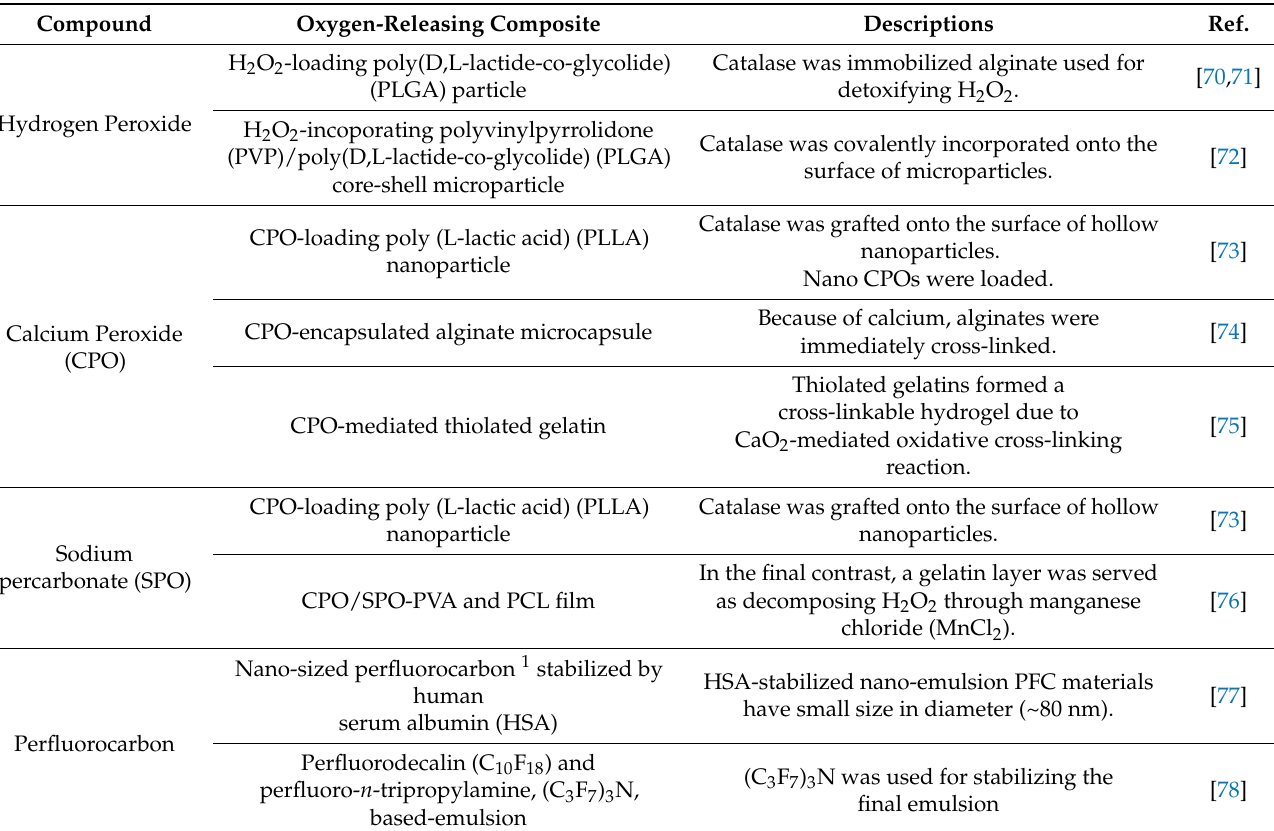
Table 3. The oxygen-releasing composites from different oxygen releasable